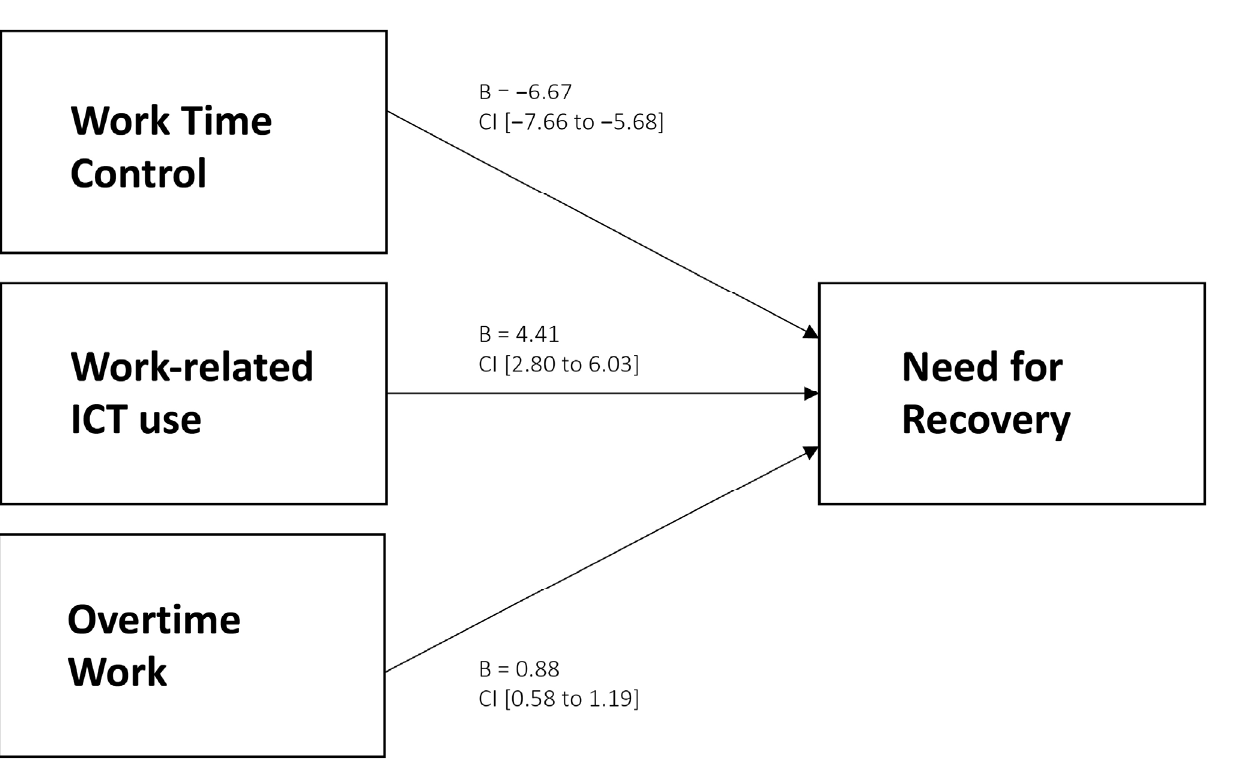
Figure 1. Associations from the multiple linear regression analysis of relations between the determi- nants work time control, work-related ICT use, and overtime work and the dependent variable need for recovery. The B-values (95% confidence intervals) show the unstandardized coefficients adjusted for age, gender, and children at home.